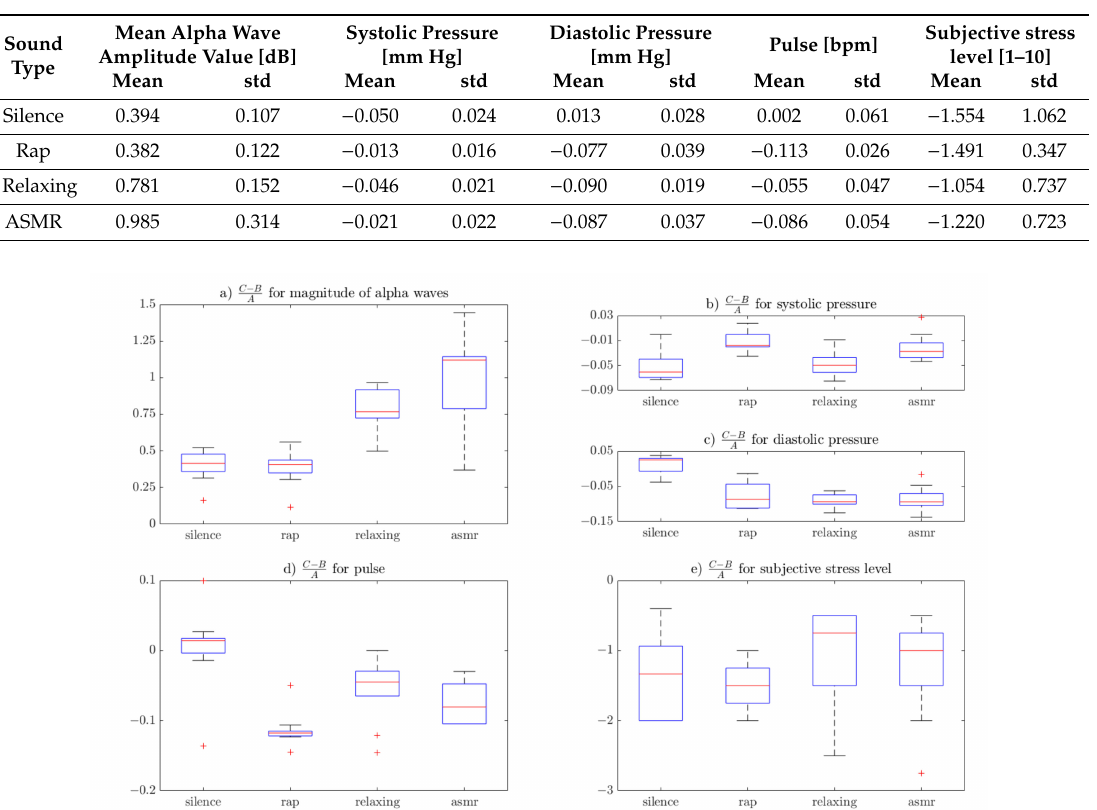
Figure 1. Visualization of the measurements (i.e., the mean value and the standard deviation). ( a ) The EEG measures; ( b ) and ( c ) are the pressure measure; ( d ) pulse; and ( e ) subjective stress level. Table 4. The mean and the standard deviation of the CBA ratio.